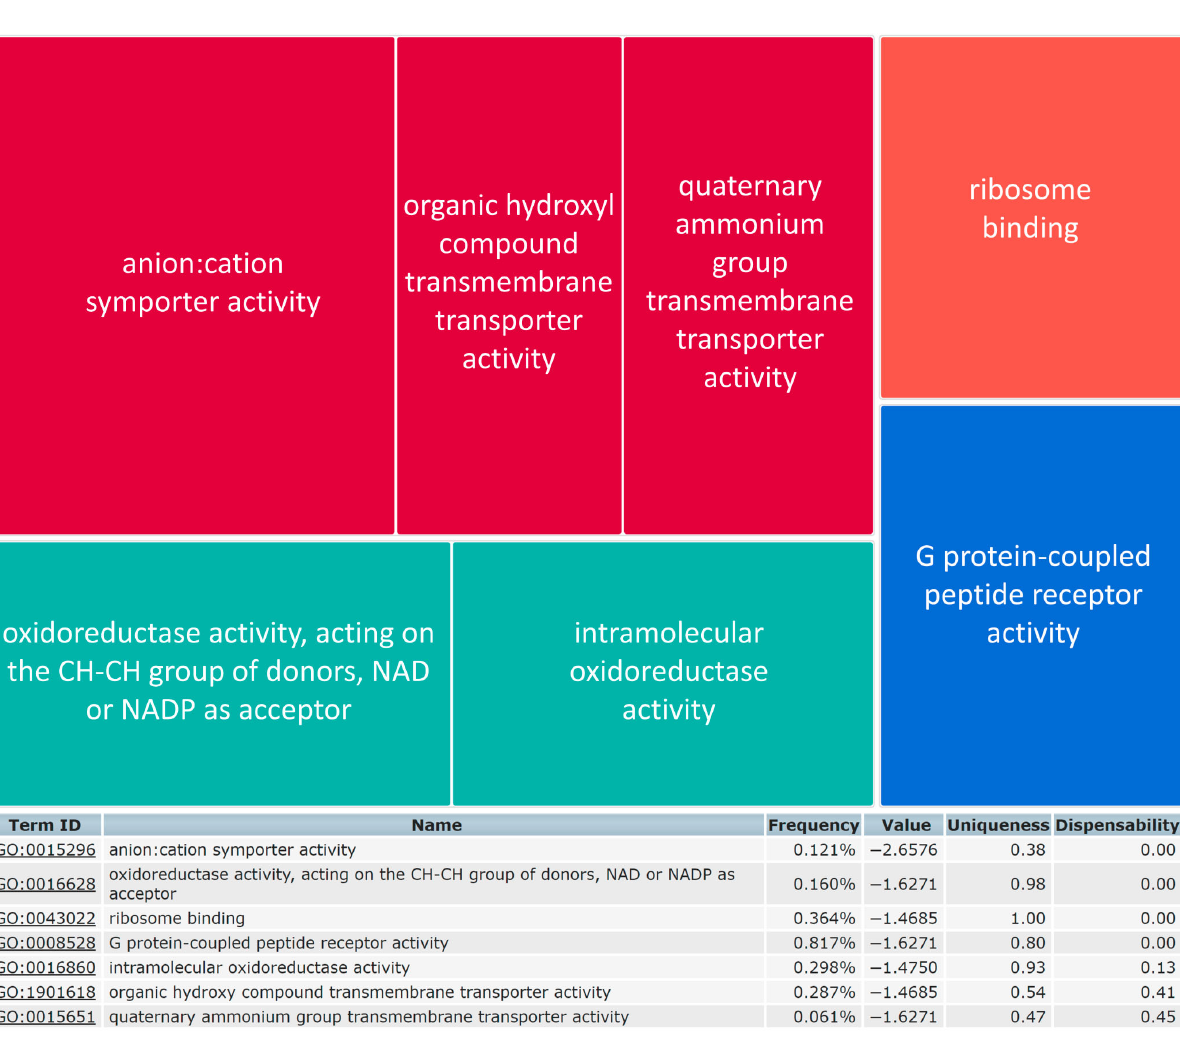
Figure 4. Reduction in pathway complexity for TMEM147. Reduction in Gene Ontology Molecular Function terms for TMEM147 interactors based on enriched Gene Ontology Molecular Function terms identified by String-db 11.0b, with target being a “Small” output list in REVIGO. Alternatively, non-redundant GO terms are provided by REVIGO in Scatterplots and Interactive Maps, as shown in Supplementary Figure S5. For clarity, fonts for TreeMap and table outputs have been enhanced compared to the original REVIGO display.